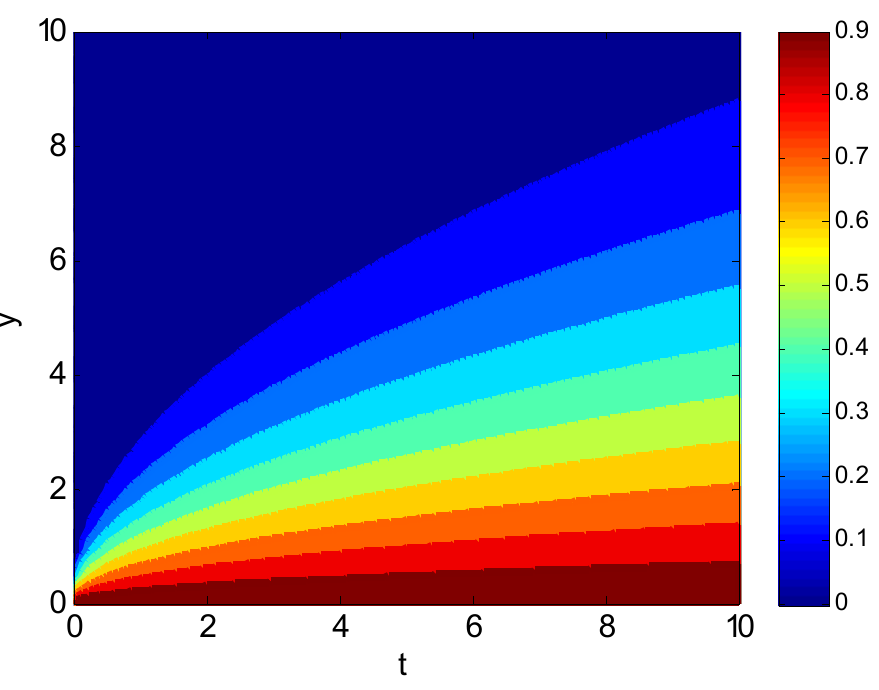
Figure 6. Contours of temperature profile.